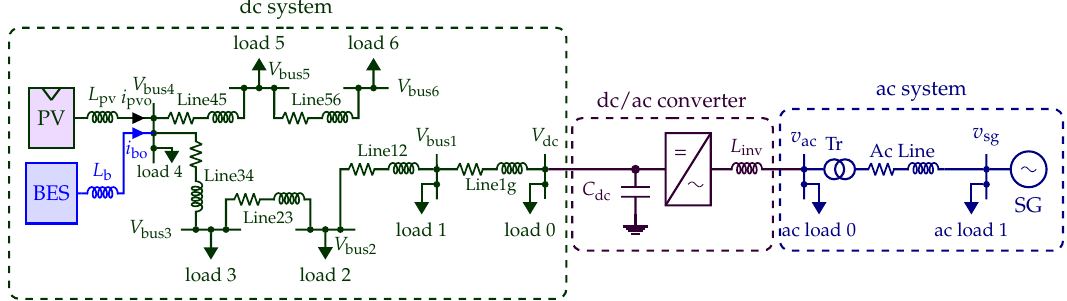
Figure 2. A hybrid dc/ac system to study the abrupt power disturbances of the photovoltaic (PV) generator. Table 1. Parameters of dc